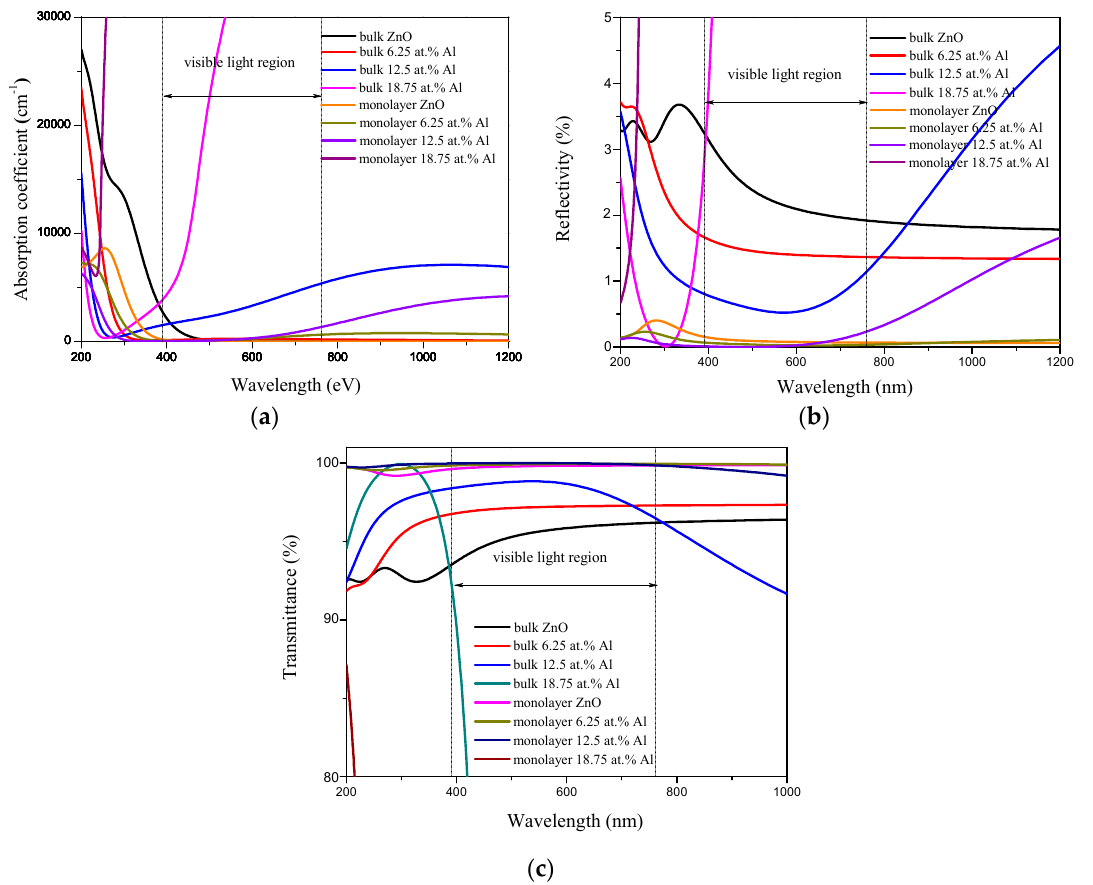
Figure 6. The imaginary part of the dielectric function of ZnO bulk and monolayer doped with different Al concentrations.